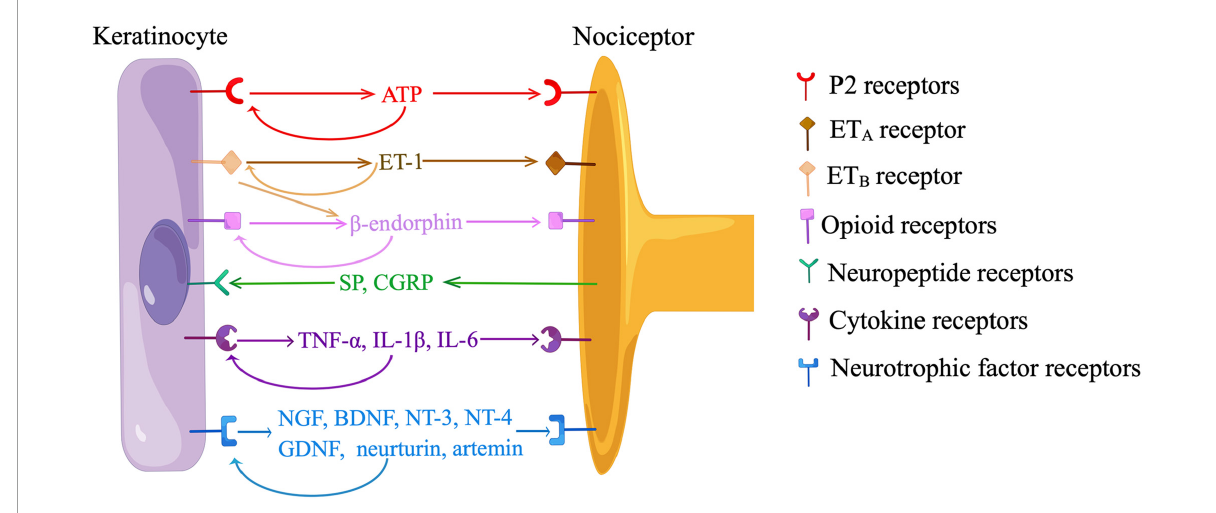
FIGURE3 Communications between keratinocytes and nociceptors. ATP, adenosine-5’-triphosphate; ET-1, endothelin-1; ET A , endothelin-1 receptor A; ET B , endothelin-1 receptor B; SP, substance P; CGRP, calcitonin gene-related peptide; TNF- α , tumor necrosis factor- α ; IL, interleukin; NGF, nerve growth factor; BDNF, brain-derived neurotrophic factor; NT, neurotrophin; GDNF, glia-derived neurotrophic factor. Neurotransmission between keratinocytes and sensory neurons is dependent on the release of ATP from keratinocytes and the activation of P2 receptors on nociceptors. Keratinocytes produce ET-1, which binds to ET A on nociceptors to evoke pain. ET-1 also activates ET B on keratinocytes, stimulating the release of β -endorphin, which binds to opioid receptors on nociceptors to relieve pain. Keratinocytes participate in neuroinflammation by producing neurotrophic factors and pro-inflammatory cytokines in response to neuropeptides released from nociceptors. Keratinocytes also express receptors of ATP, β -endorphin, neurotrophic factors, and pro-inflammatory cytokines, indicating the existence of paracrine and/or autocrine mechanisms. (By